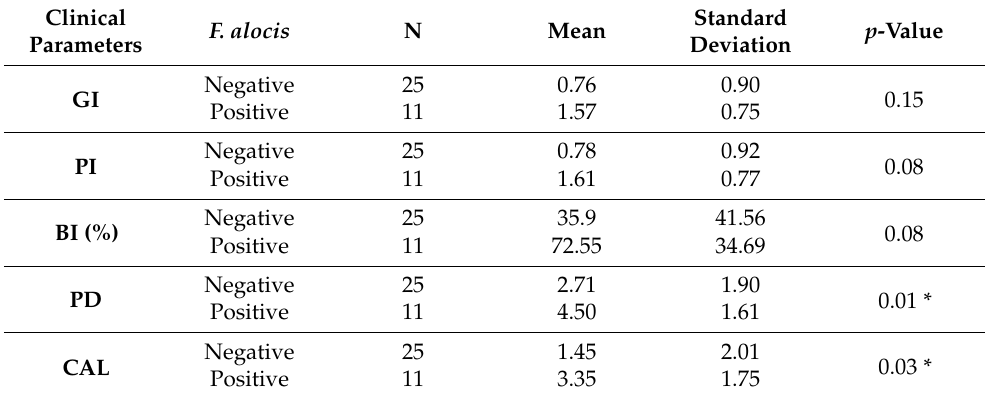
Table 4. Correlation of clinical parameters with the presence or absence of F. alocis .